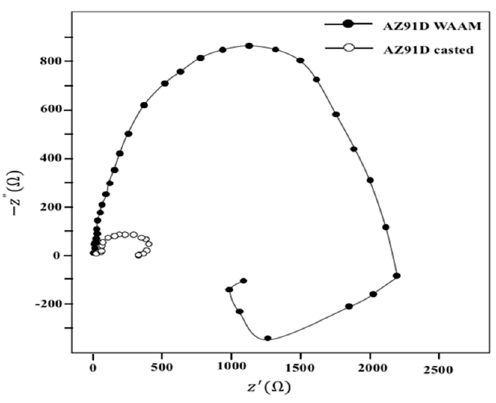
Figure 7. EIS results of AZ91D WAAM and AZ91D casted [27] 3.5 wt% NaCl. Copyright 2008, Elsevier.